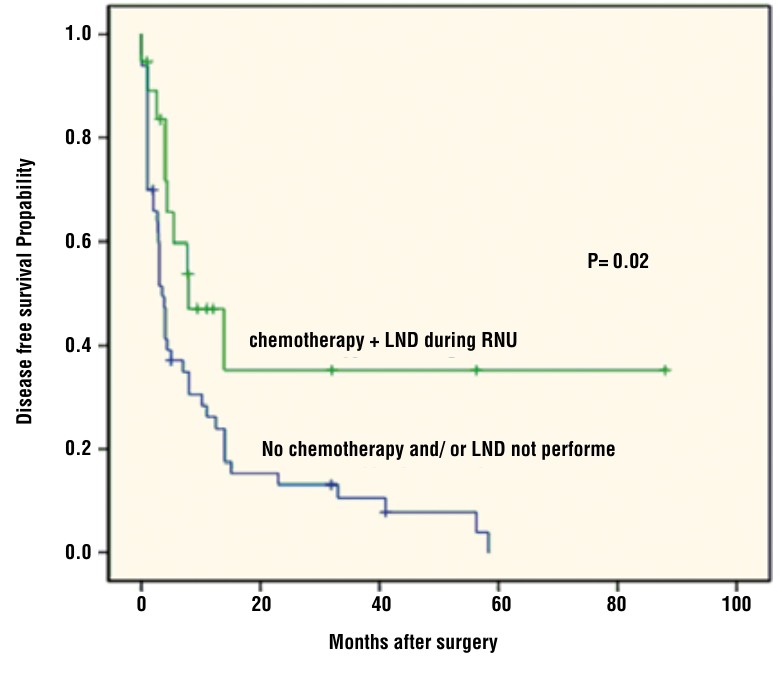
Figure 1 - Disease free survival probabilities based on whether peri-operative chemotherapy and LND were included in the management of T4 uTuC.